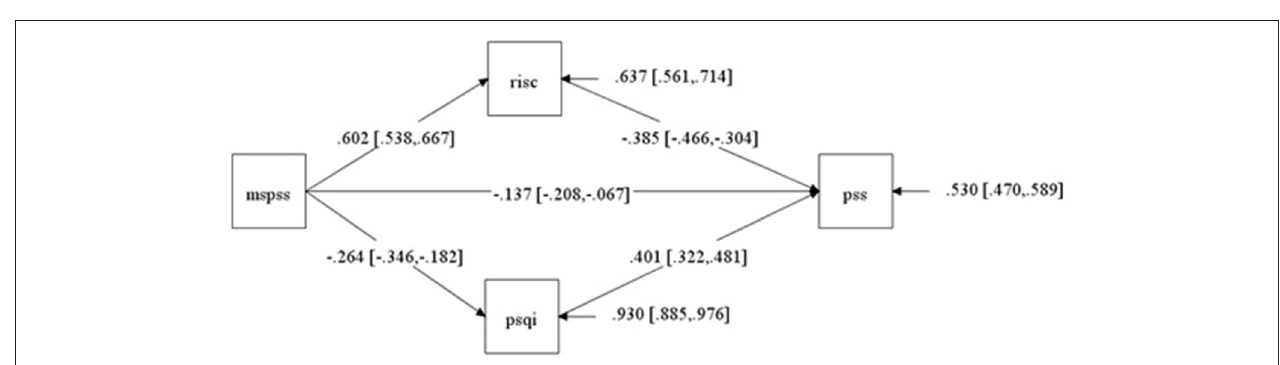
FIGURE 3 | Path analysis of PSS, MSPSS, PSQI, and CD-RISC-10.